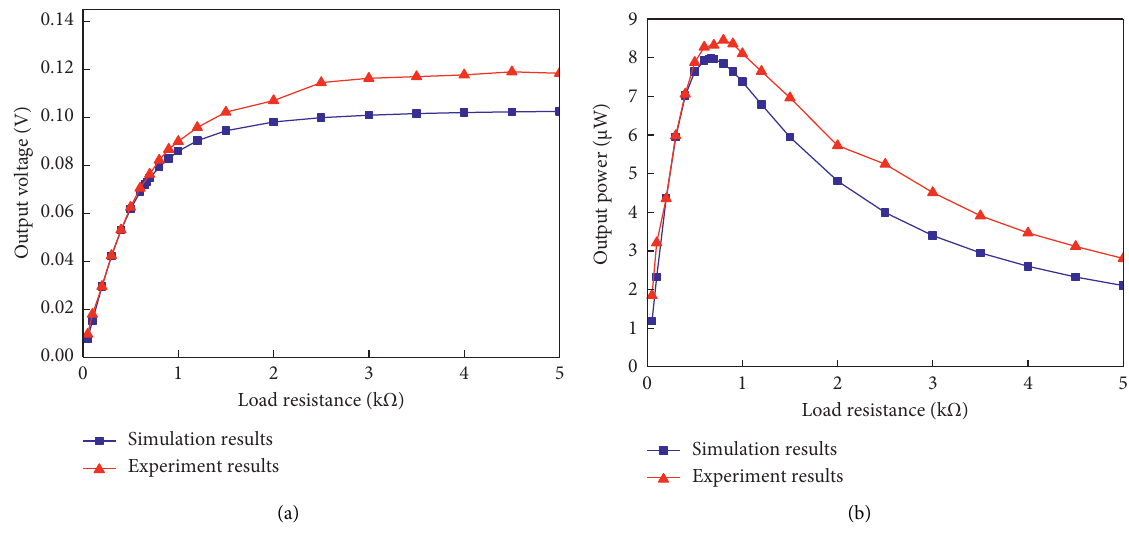
Figure 20: Voltage and power response with different resistance: (a) resistance-voltage curves and (b) resistance-power curves.